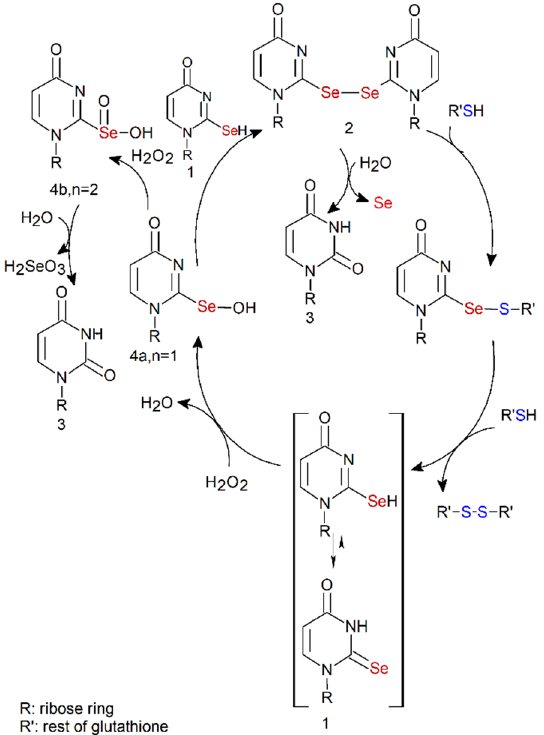
Scheme 3. Mechanism of oxidation of Se2U in the presence of oxidative and reducing